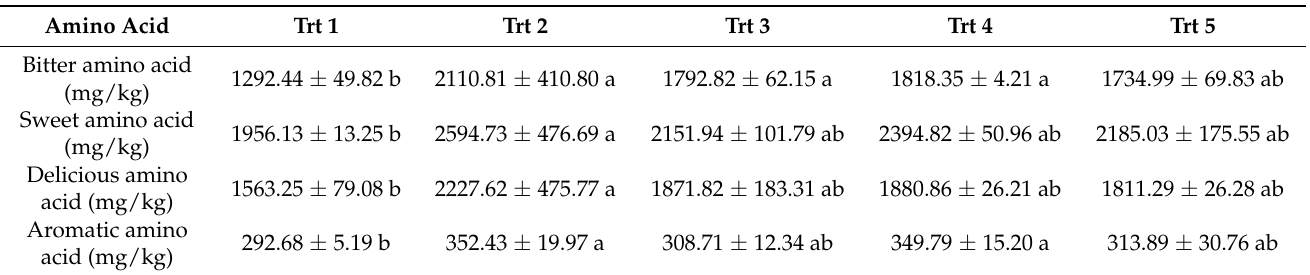
Table 4. Accumulation of flavoring amino acids in the pericarp of Z. planispinum in different plant- ing combinations.